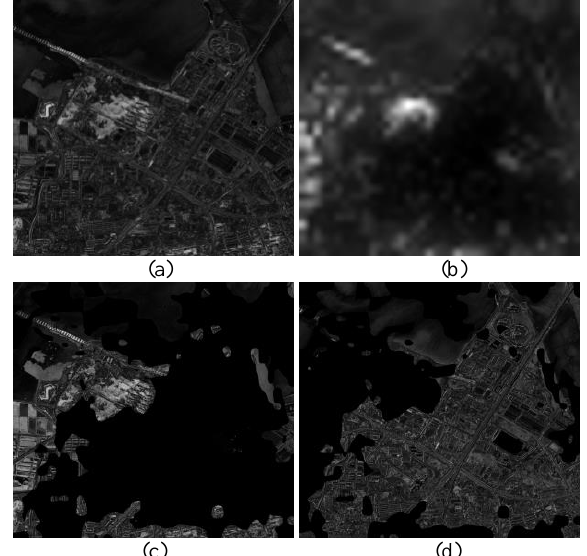
Figure 5. Intermediate results of saliency. (a) The change intensity image; (b) the saliency map; (c) the salient region; (d) the non-salient region.